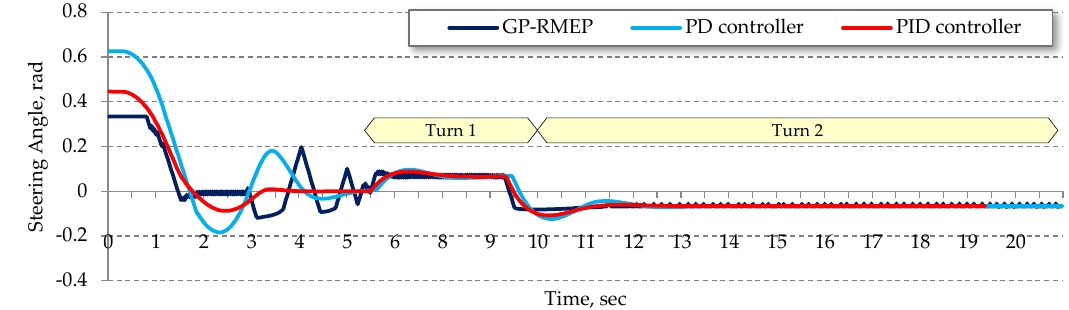
Figure 9. The dynamics of the steering angle of the car steered by the sample best-evolved SAF shown in Equation (8) in snowy ( µ = 0.5) road conditions.